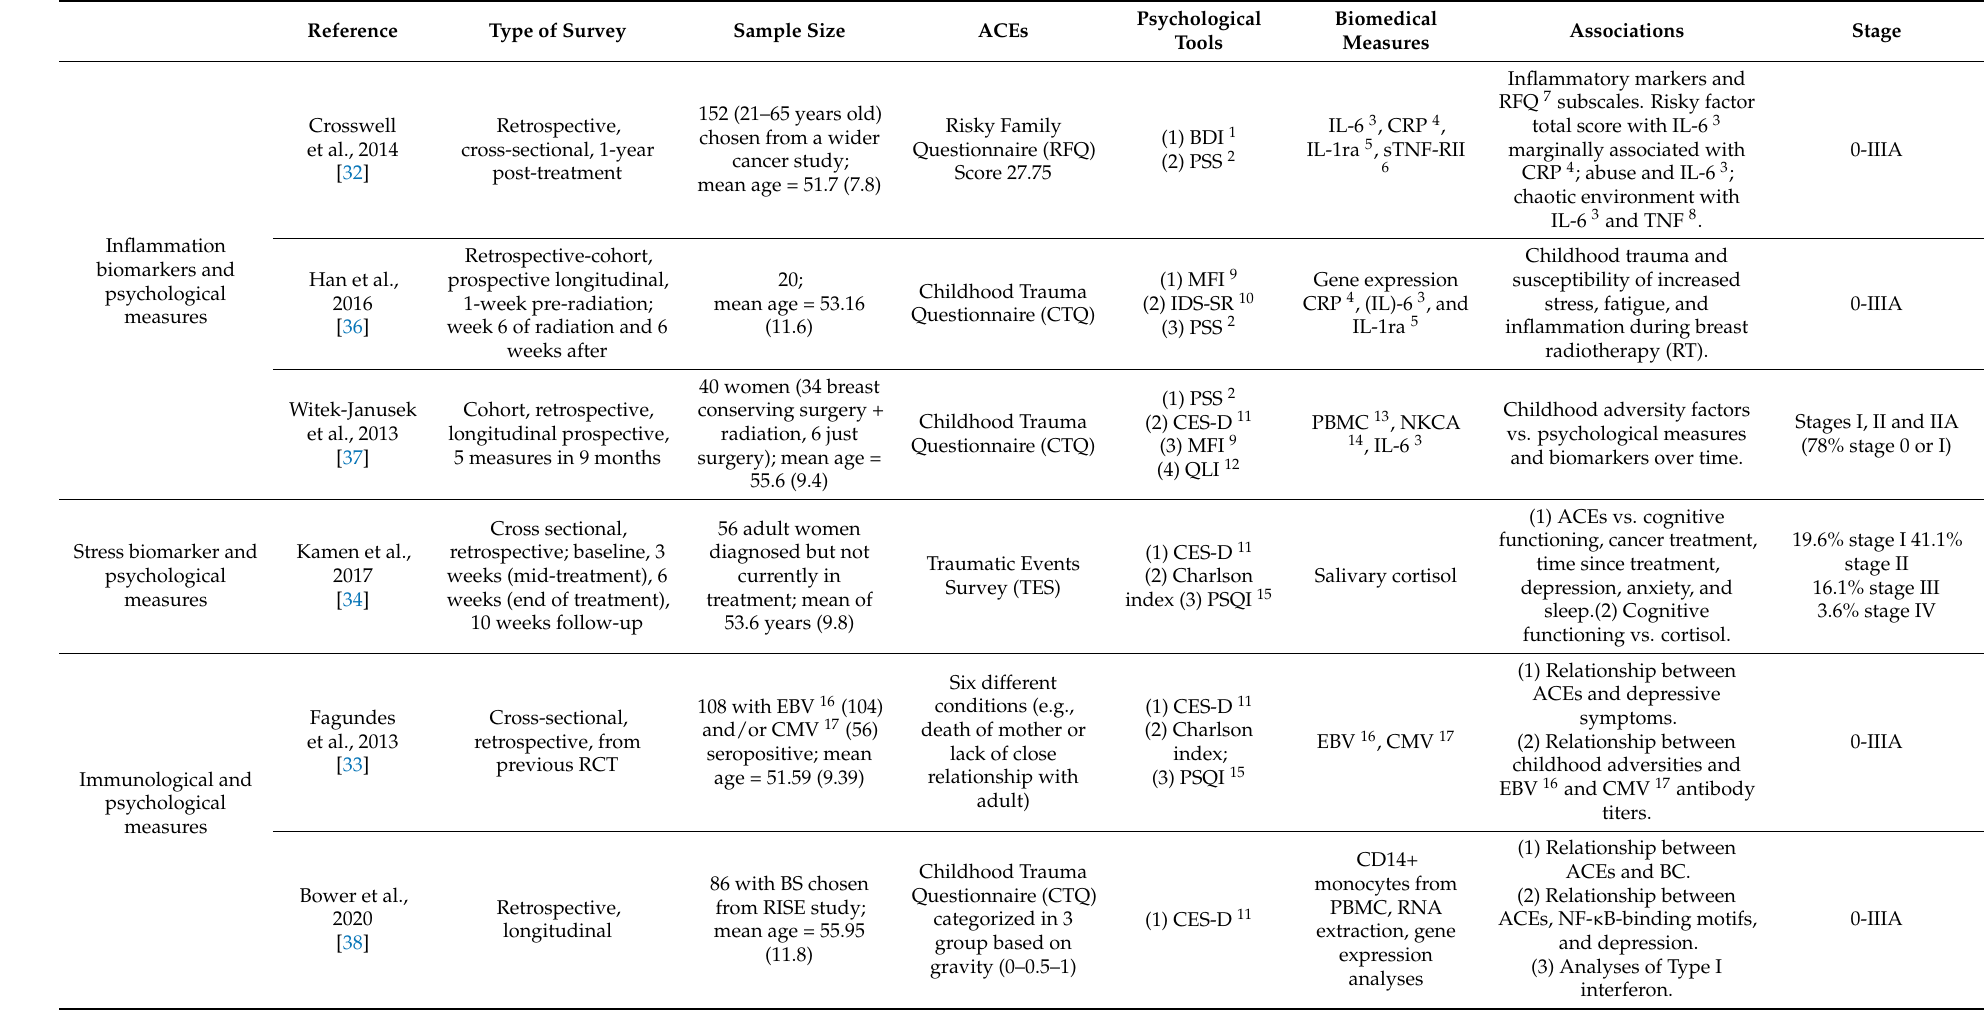
Table 1. Studies’ characteristics and association between ACEs and adverse clinical